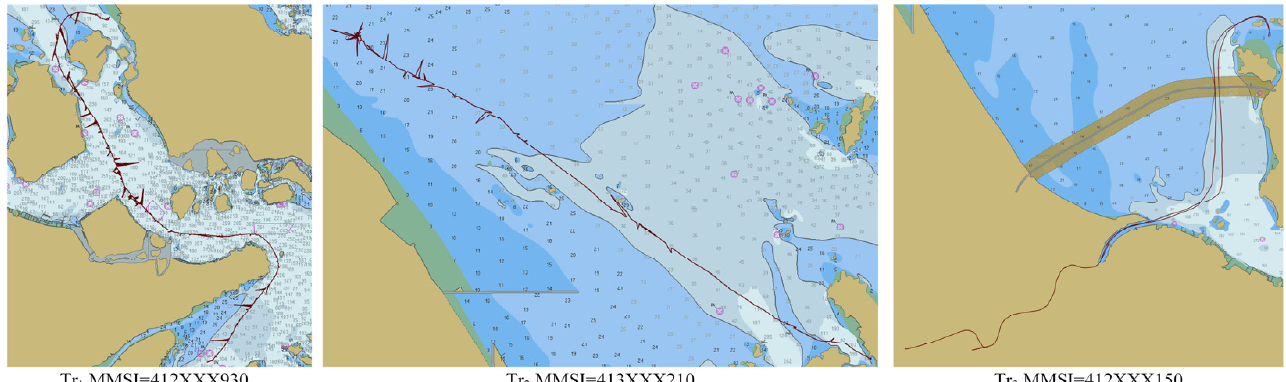
Figure 7. Trajectories Tr 1 , Tr 2 , and Tr 3 . Tr Tr Tr 2 , and 3 . Table 3. Trajectories in case